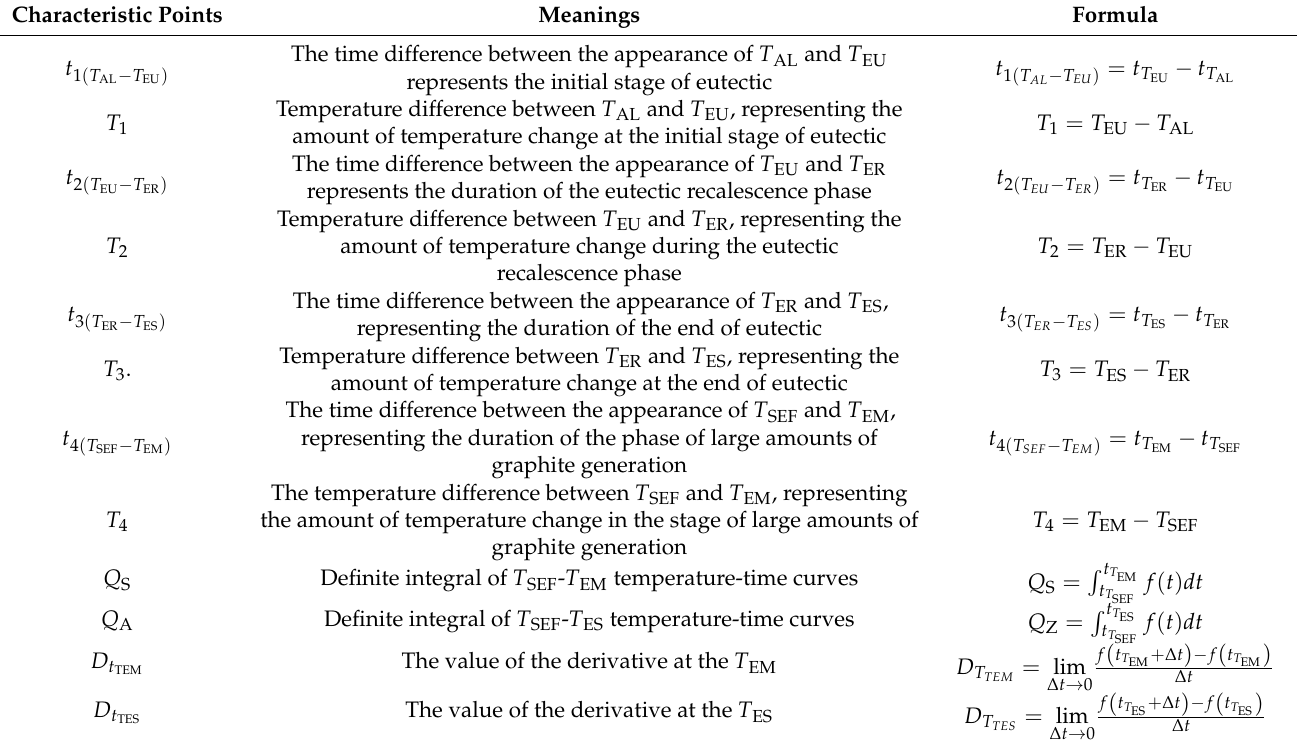
Table 6. The meanings and calculation formulas of the thermal analysis characteristic